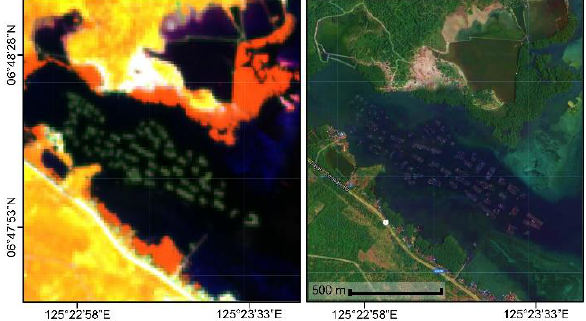
Figure 7 . Mangroves along the Davao Gulf shoreline in Tile 51NYH that are unaccounted for in the MVI-based 2019 Mangrove Extent Map of the Philippines.